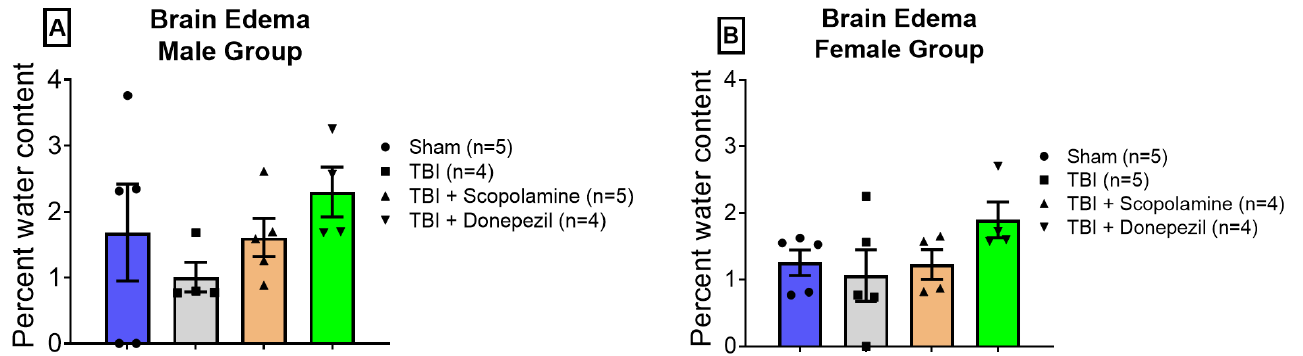
Figure 5. Effect of TBI and subchronic muscarinic modulation on brain edema. Graphs ( A , B ) represent the percentage water content in the brains of the male and female mice, respectively. Data are presented as mean ± SEM.